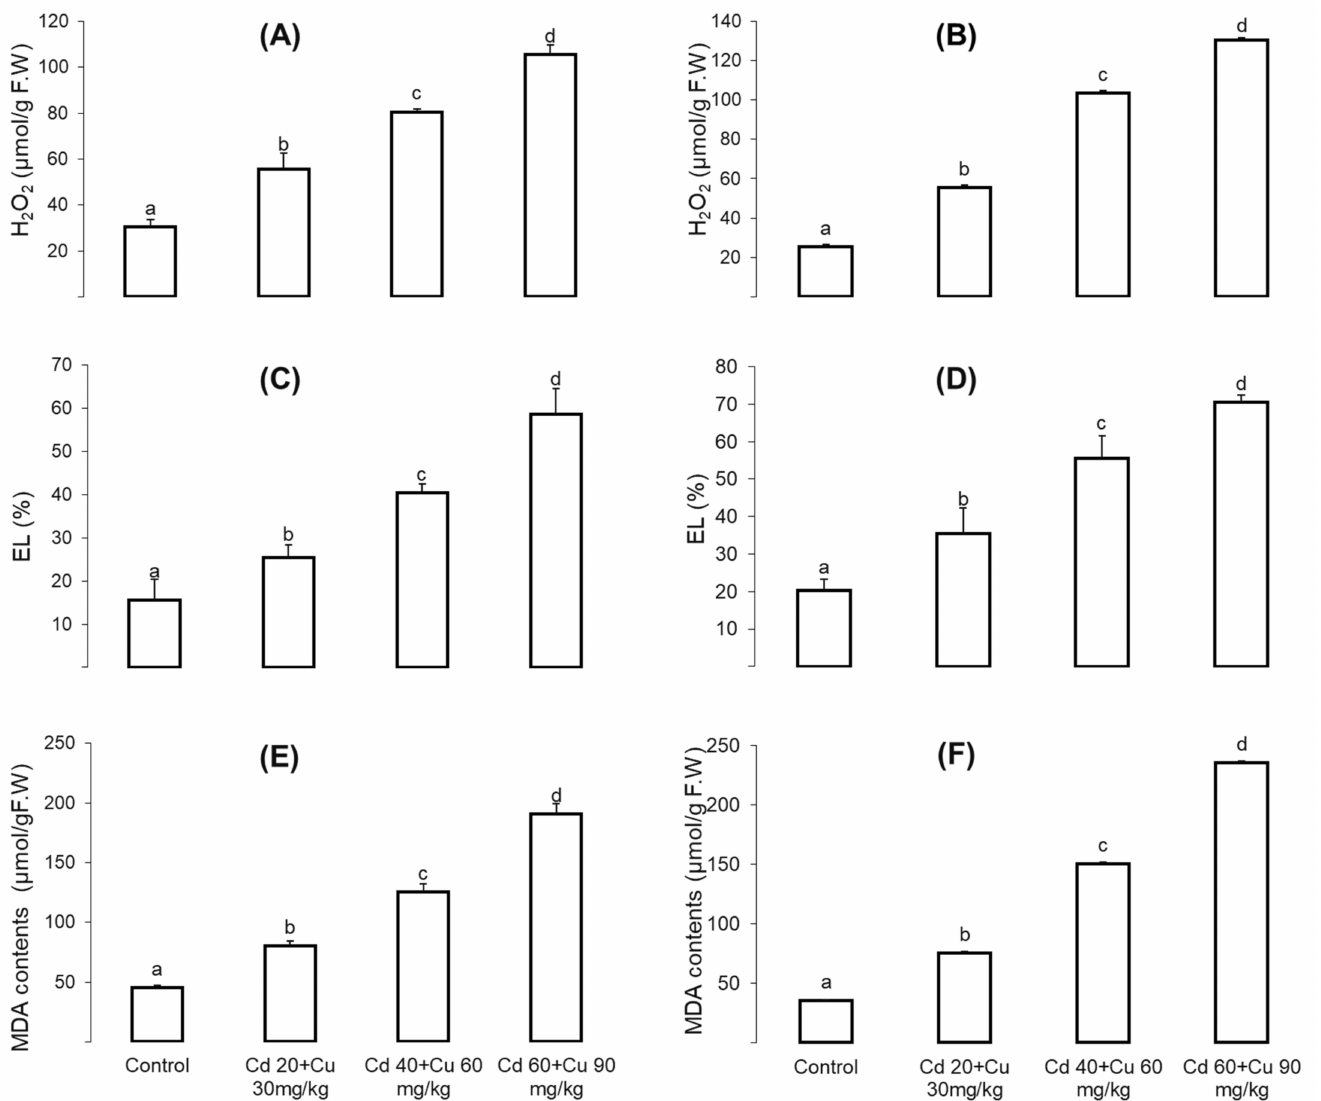
Figure 3. The effect of different Cd and Cu treatments (0, Cd 20 + Cu 30 mg/kg, Cd 40 + Cu 60 mg/kg, and Cd 60 + Cu 90 mg/kg) on the shoot ( A , C , E ) and root ( B , D , F ) H 2 O 2 , EL, and MDA contents of pigeon pea plants. Bars represent means from the three independent replicates ( ± , n = 3); different letters indicate significant differences between the treatments at p <